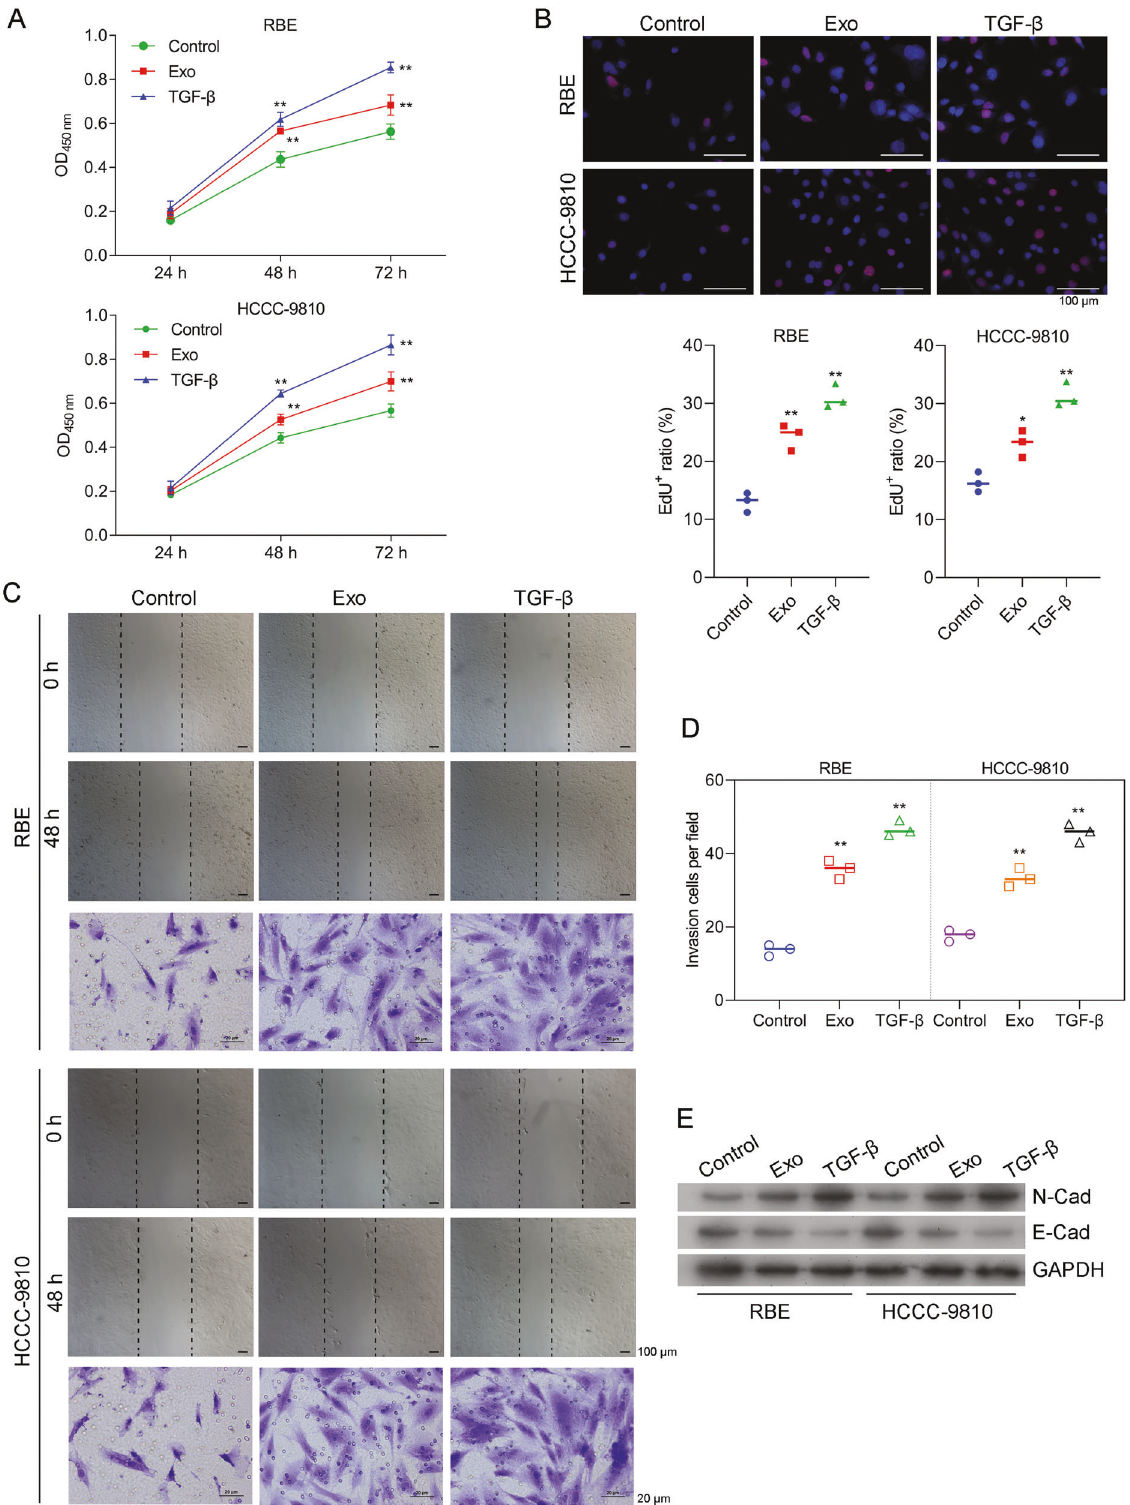
Fig. 2 TAM-secreted exosomes induced CCA cell proliferation, migration, and invasion. A THP-1 cells were treated with PMA for 24 h and then with IL-4 for the next 24 h to induce macrophage differentiation. The cells were then washed and treated with 200 ng/mLTWEAK for 24 h to release exosomes. Exosomes were extracted from the CM of TAMs. RBE (upper panel) and HCCC-9810 (lower panel) cells were co-cultured with exosomes (Exo) or treated with TGF- β . Cell proliferation was measured by the CCK8 assay. B Representative images of Edu staining assays and a summary of results from three different experiments are shown. C Cell monolayers were wounded and images were acquired at 0 and 48 h. The respective images of Transwell assays are shown (lower panel). D The results of cell invasion assays as summarized from three independent experiments. E Cells were treated as described above and then lysed for western blot assays. * p < 0.05 and ** p < 0.01 compared with the control group. Cell Death and Disease (2022)